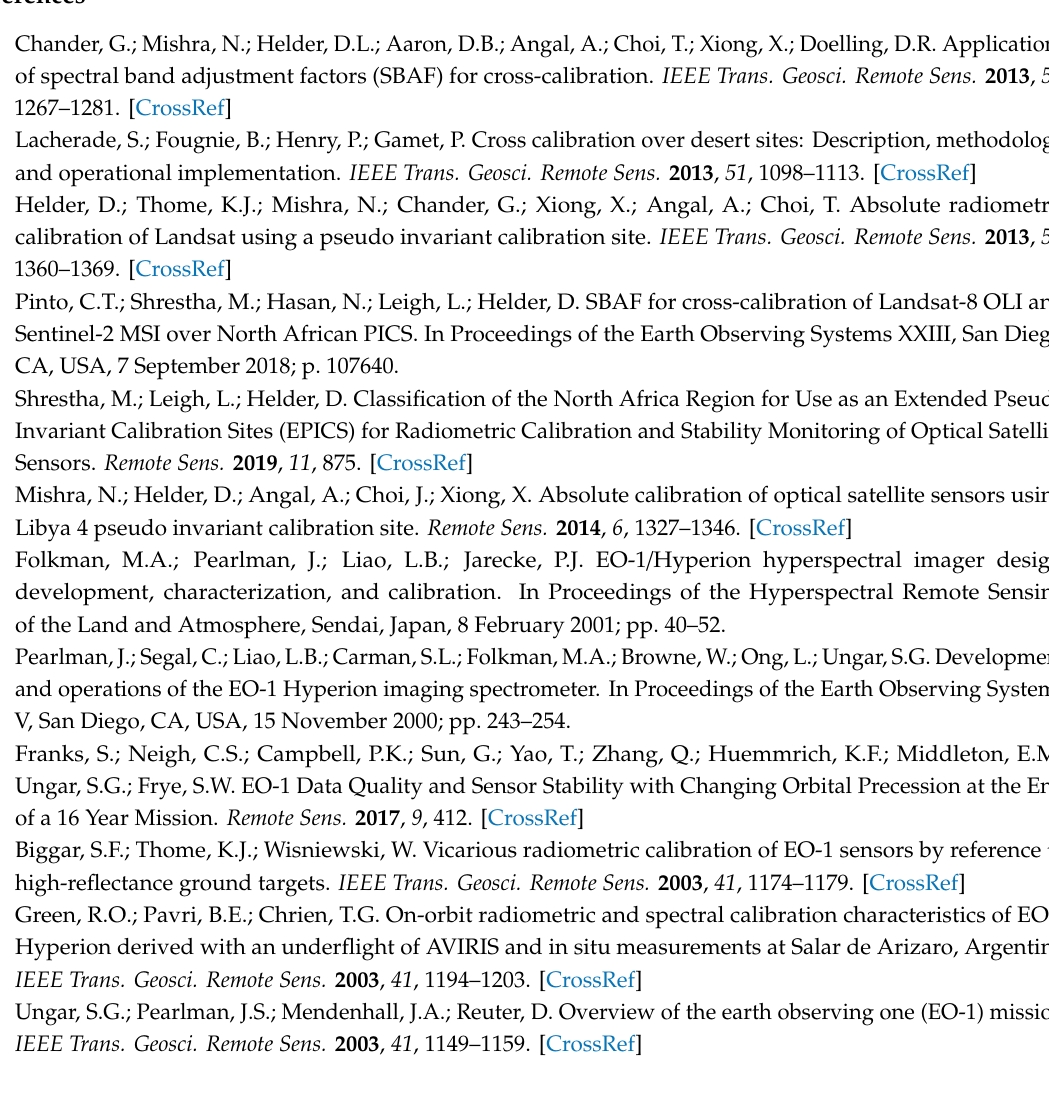
Figure A16. Estimated representative hyperspectral profile of Cluster 19 and its resultant uncertainty.